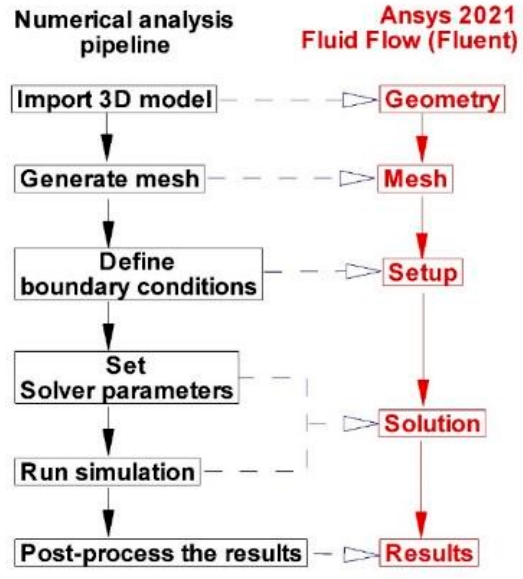
Figure 6. Pipeline for numerical analysis.